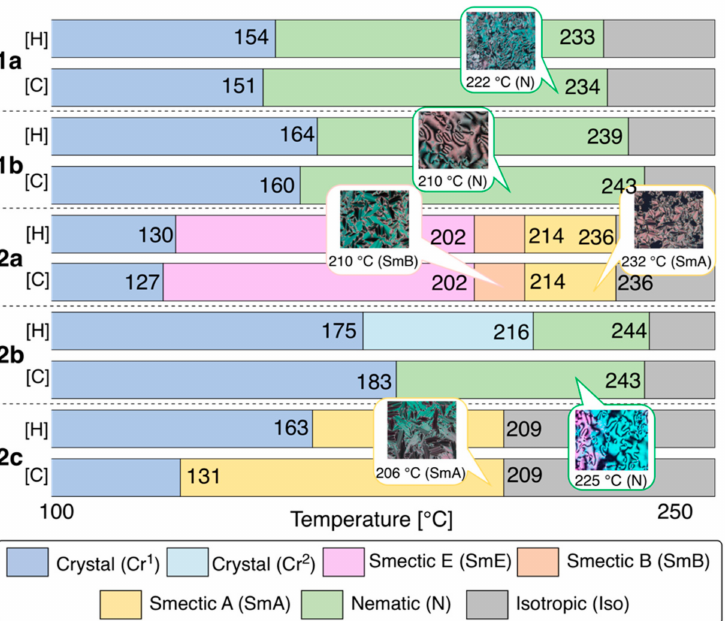
Figure 5. Phase transition behaviors of the bistolane derivatives during the 2nd heating [H] and cooling [C] processes (scan rate: 5.0 ◦ C min − 1 ). POM texture images of the LC phases are also